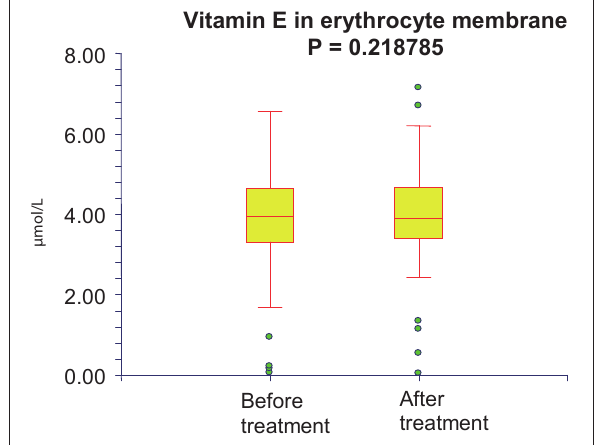
Fig. 4. Levels of vitamin E in erythrocyte membranes before and after RH treatment.